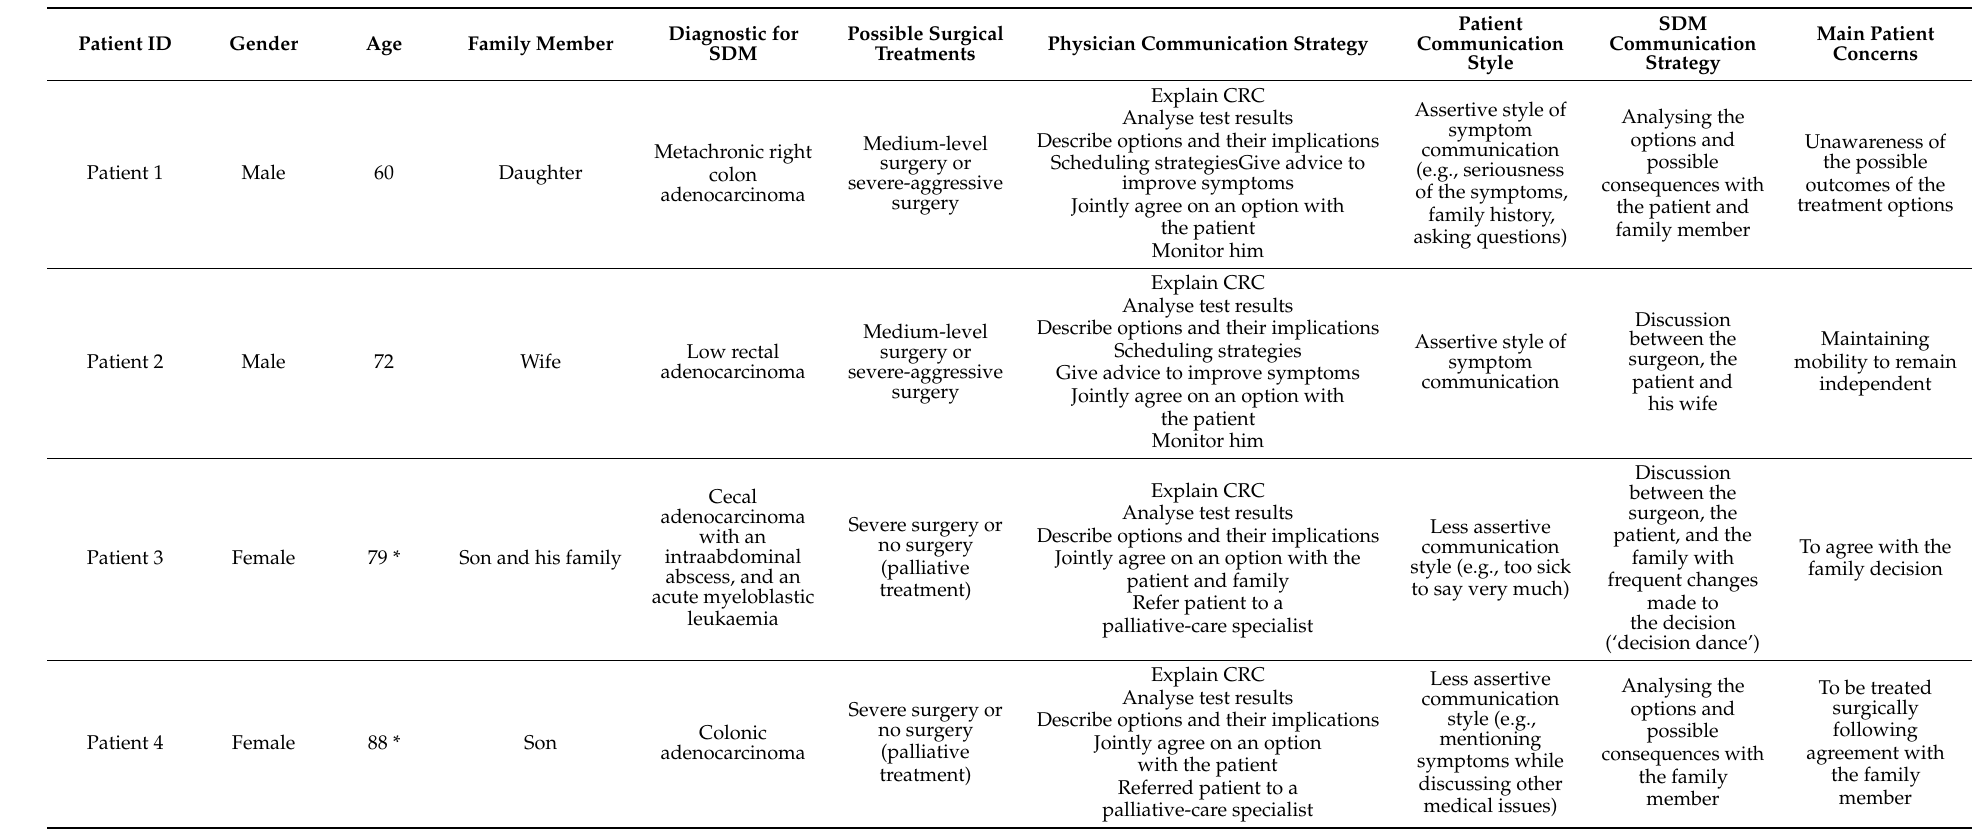
Table 1. Patient characteristics related to the SDM in the PPM